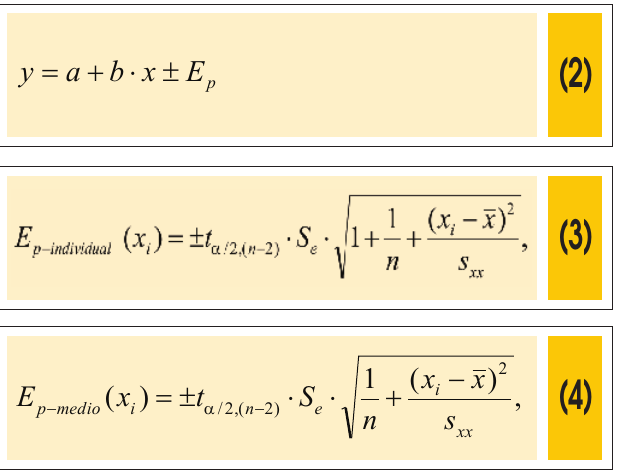
model described in equation (2). The prediction errors, E individual and mean values of the correlation curve were calculat - ed using equations (3) and (4), respectively. The significance value α, which is necessary to determine the confidence interval of the correlation curve, is equivalent to the value employed in the cal - culation of the concrete characteristic strength, i.e., α = 5.0% [19]. Among the various references, detailed descriptions of the linear regression process as well as the equations used for the determi - nation of the prediction error can be found in [18].